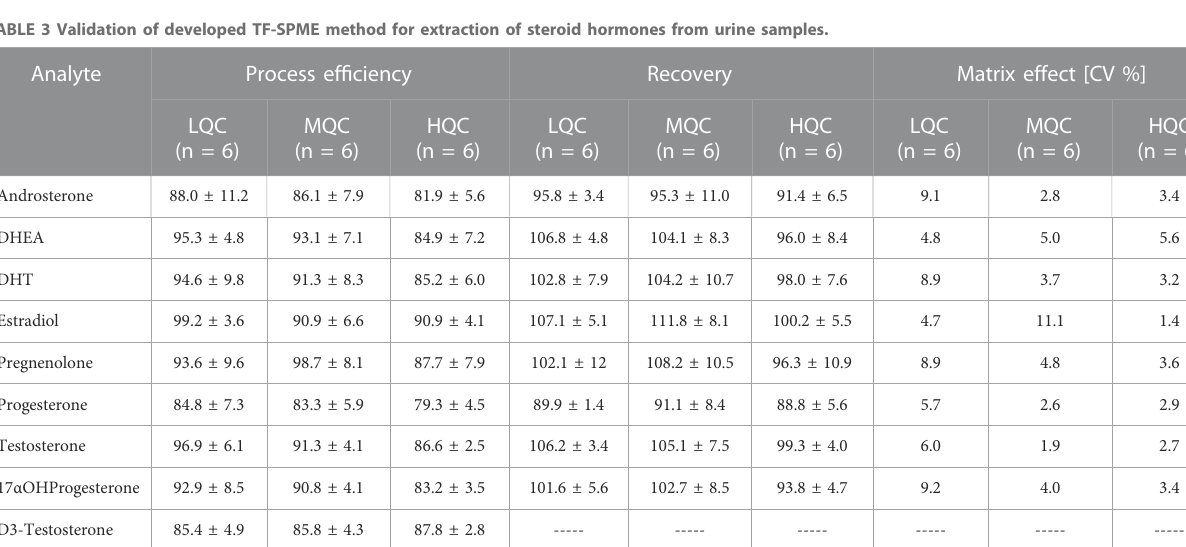
Table legend: LQC — low quality control, MQC — middle quality control, HQC — high quality control, CV — coef fi cient of